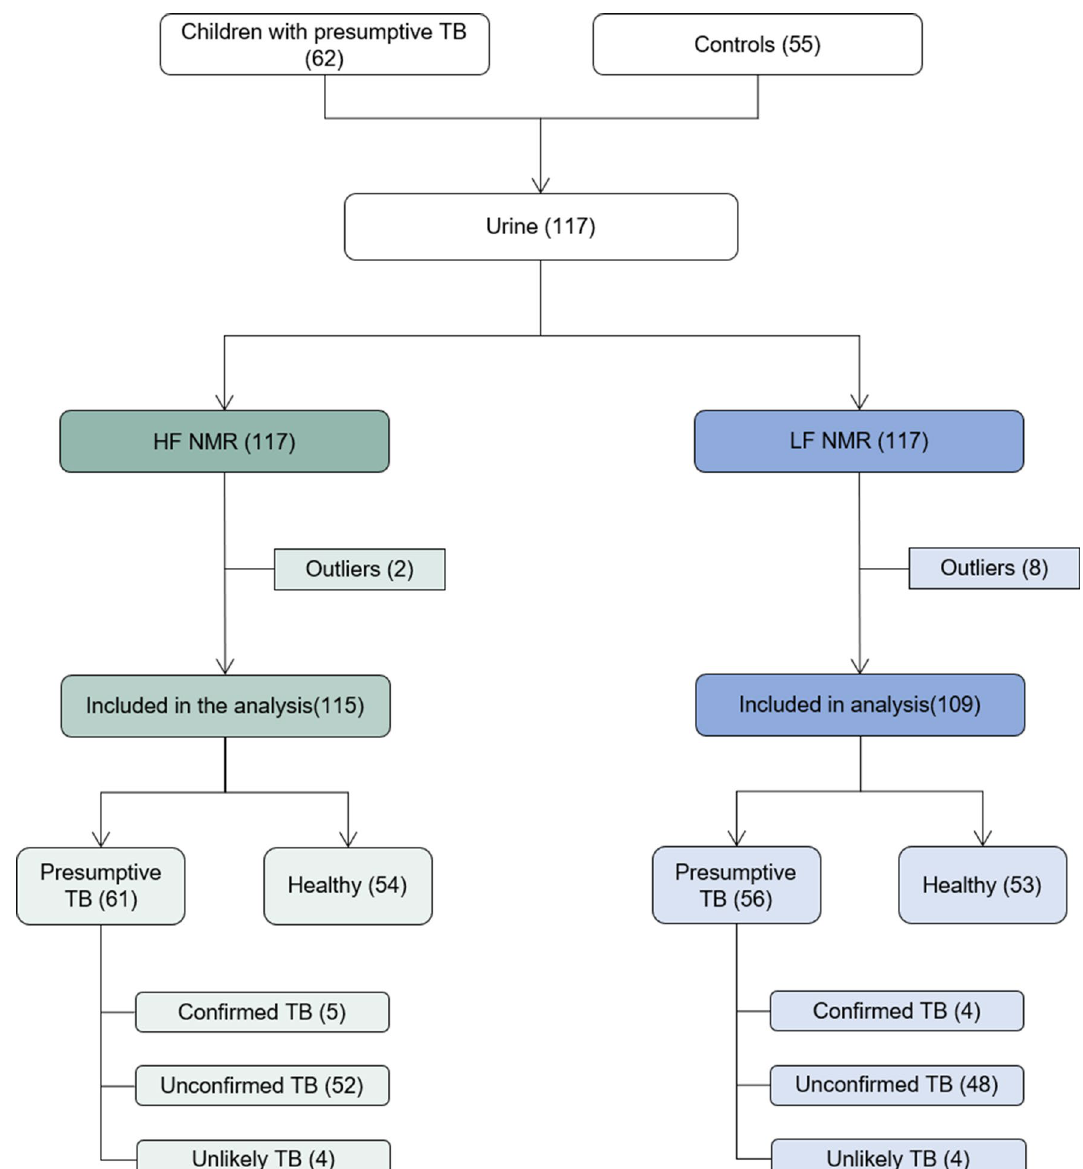
Figure 1. Description of the children who participated in the study according to the nuclear magnetic resonance equipment used to acquire the urine samples spectra and the classification of the patients in the study group. NMR nuclear magnetic resonance, HF high-field, LF low-field, TB